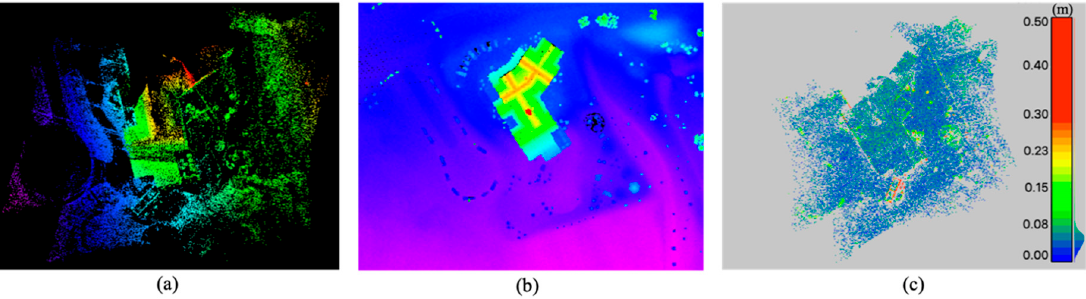
Figure 14. ( a ) The derived image-based sparse point cloud through the proposed automated aerial